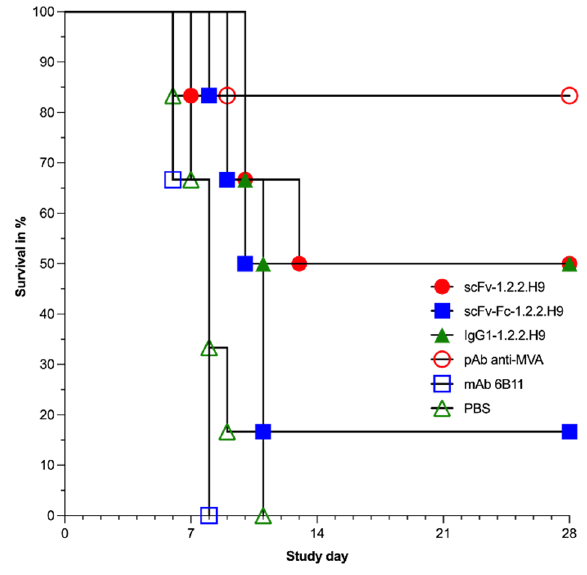
Figure 10. Survival rate in % of mice during the in vivo passive immunization.